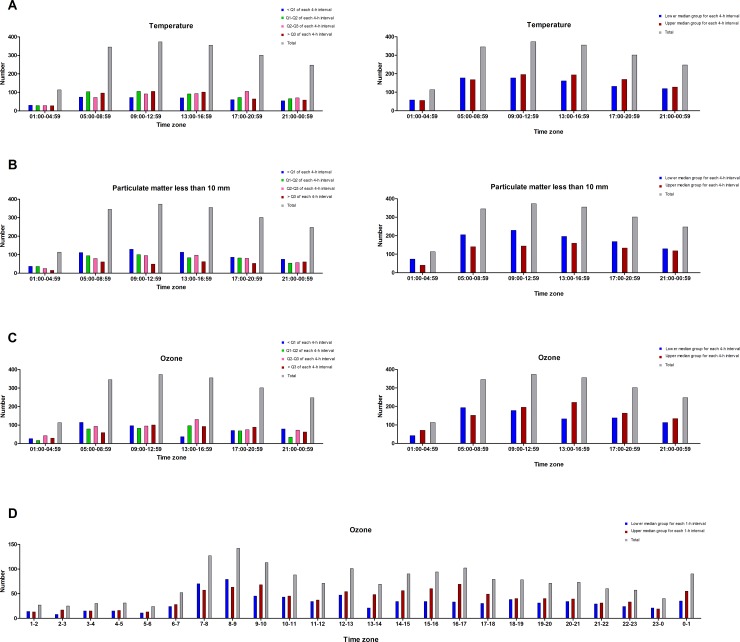
Time-specific stroke onset pattern with data on temperature, PM10, and O3 for the time of stroke onset divided into quartiles and medians for each 4-hour interval and O3 for the time of stroke onset divided into medians for each 1-hour interval by the average hourly values for every month during the 7-year study period.